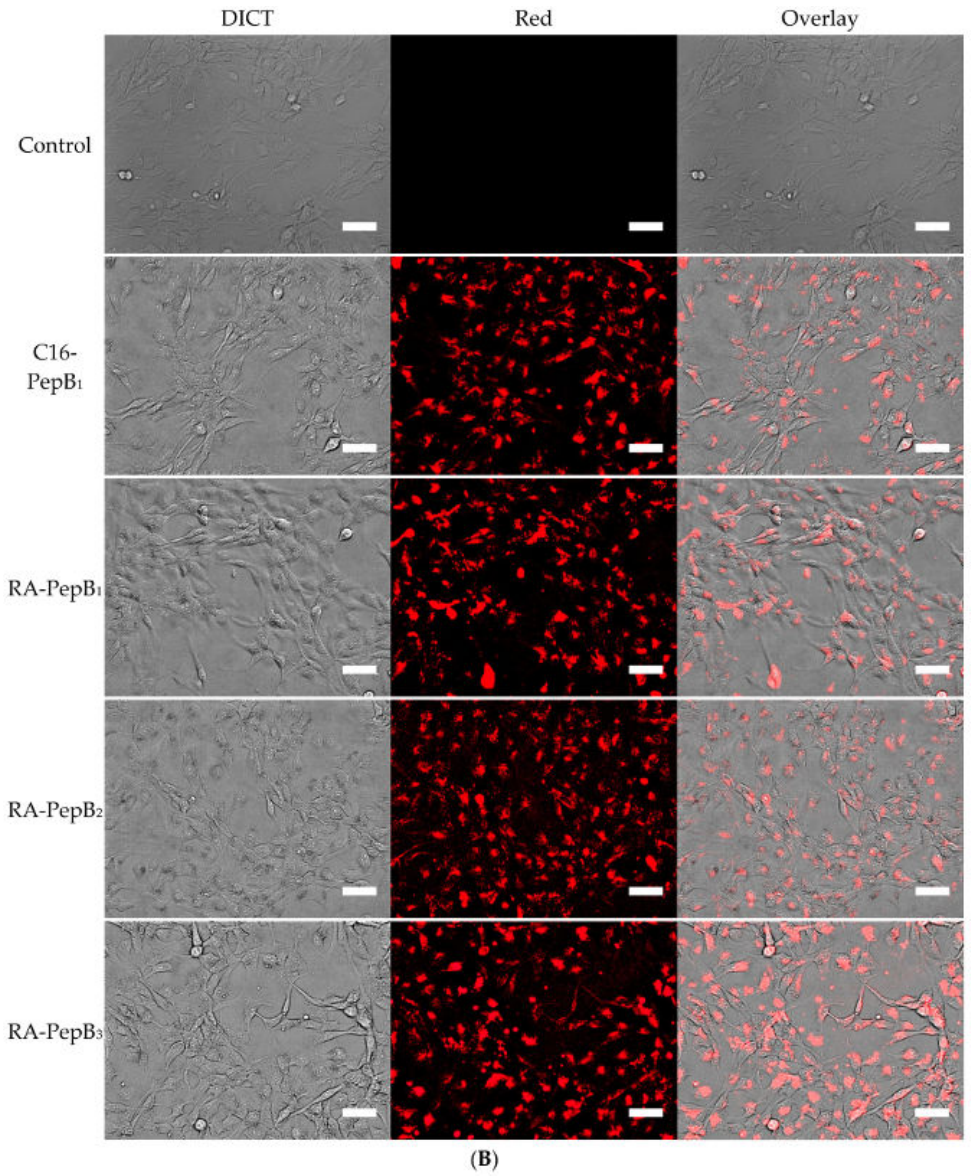
Figure 10. Lipidated PepB variant uptake results. ( A ) Lipidation of PepB significantly increased cell uptake in RVM, irrespective of the number of repeat-sequences. ( B ) Live-cell fluorescence microscopy images of RVM after 24 h treatment with 1 µ M lipidated PepB. C16-PepB 2 and C16-PepB 3 uptake profiles are identical to C16-PepB 1 . N = 3; error bars depicted as SD; * p < 0.001; scale bar = 50 µ